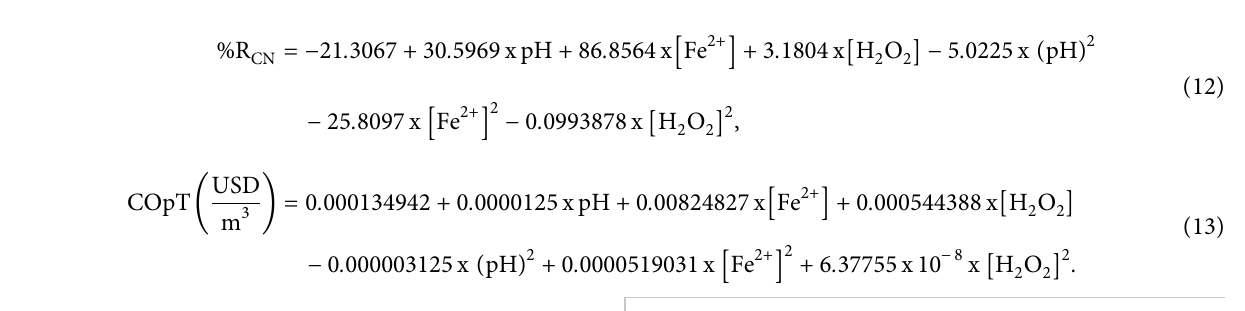
Figure 3: Efect of the H color